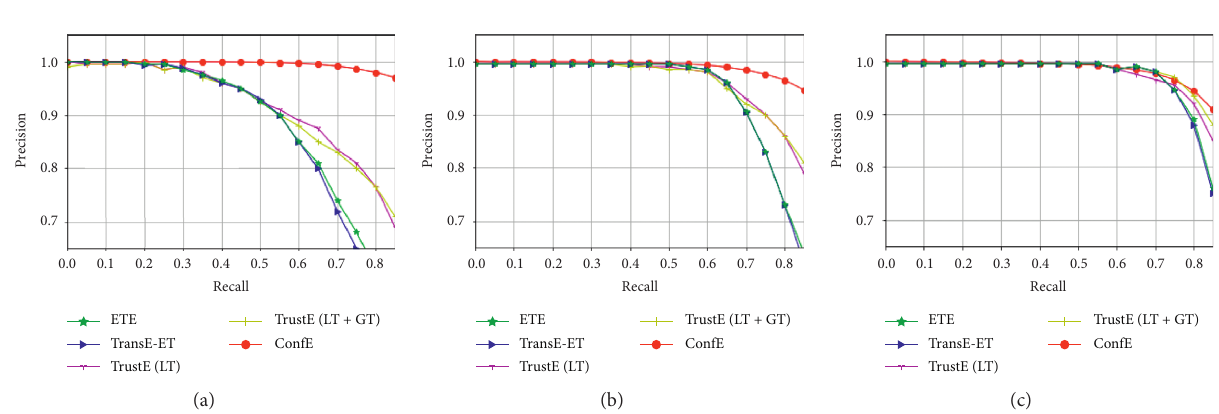
Figure 2: Entity type noise detection results. Evaluation on (a) FB15kET-N1, (b) FB15kET-N2, and (c) FB15kET-N3.